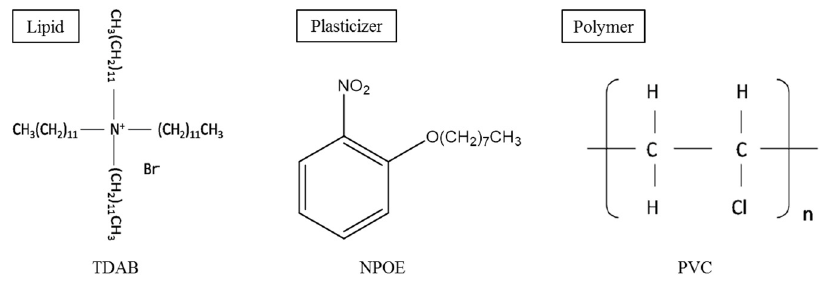
Figure 1. The chemical structures of TDAB, NPOE and PVC.